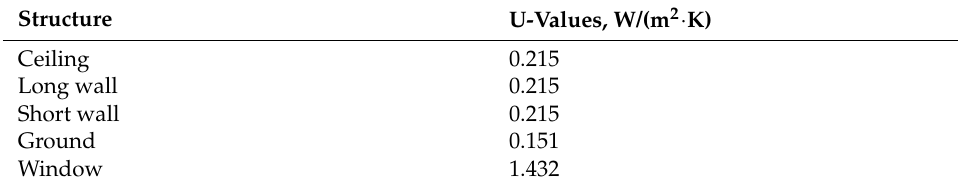
Table 2. U-values of the building